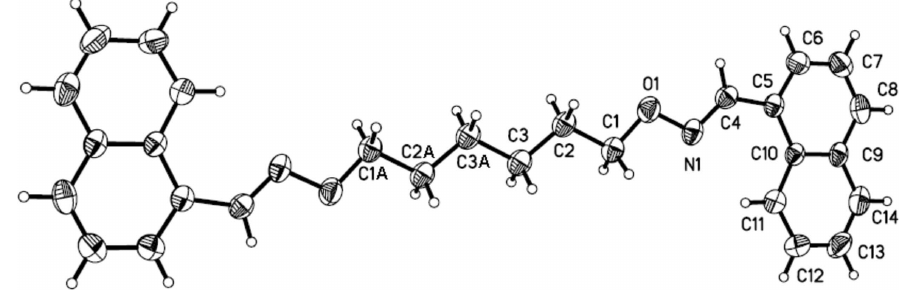
Figure 1 The molecule structure of (I) with atom numbering (symmetry code A: - x + 1, - y , - z ). Displacement ellipsoids for non- hydrogen atoms are drawn at the 30% probability level.